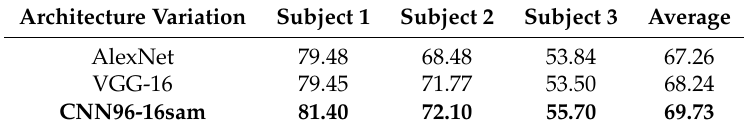
Table 9. Results of AROP phase tests using AlexNet variation (Figure 4a) and VGG-16 variation (Figure